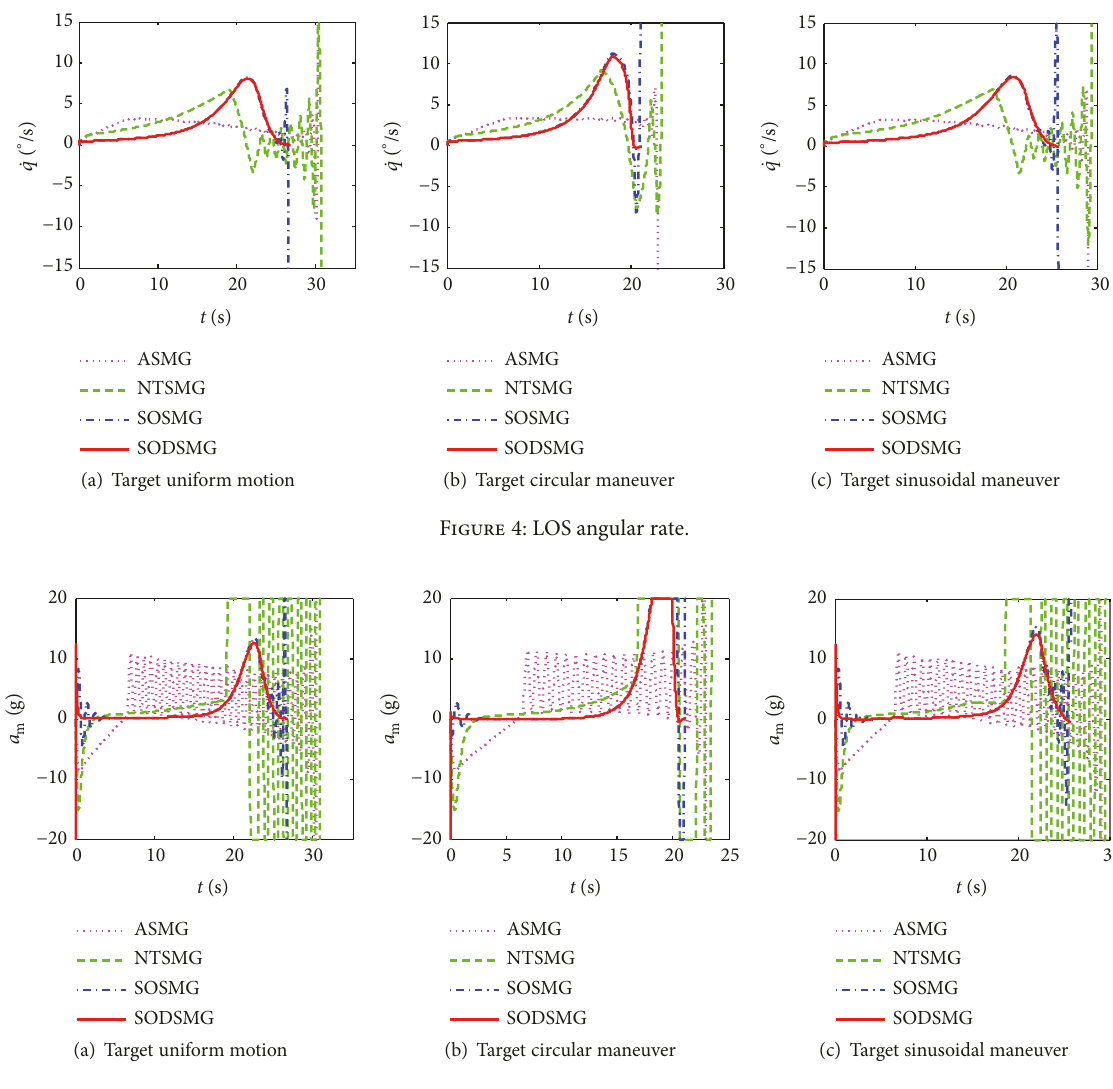
Figure 5: Missile